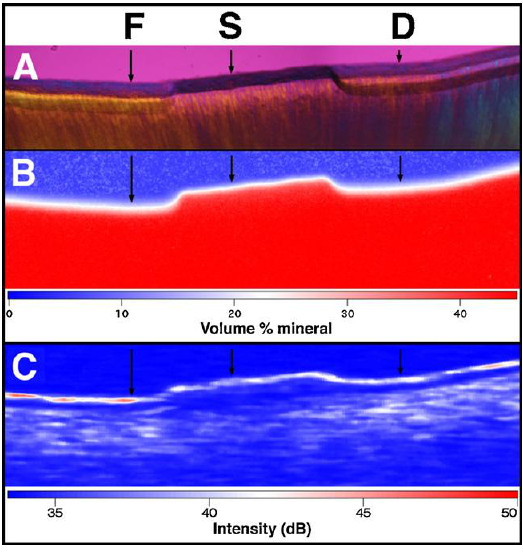
Figure 10. Measuring demineralization by polarized light microscopy (PLM), transverse microradiography (TMR), and PS-OCT images. The black arrows indicated topical fluride (F), protected sound dentin (S), and untreated demineralization area (D). PLM ( A ) shows the lesion depth on both sides (F and D) of the sound protected area. TMR ( B ) and PS-OCT ( C ) images are also shown along with the false color intensity scales. PLM and PS-OCT were superior to TMR as a tool for measuring lesion depth and cementum layer thicknesses because these measurements were much higher sensitivity to mineral loss (reprinted from reference